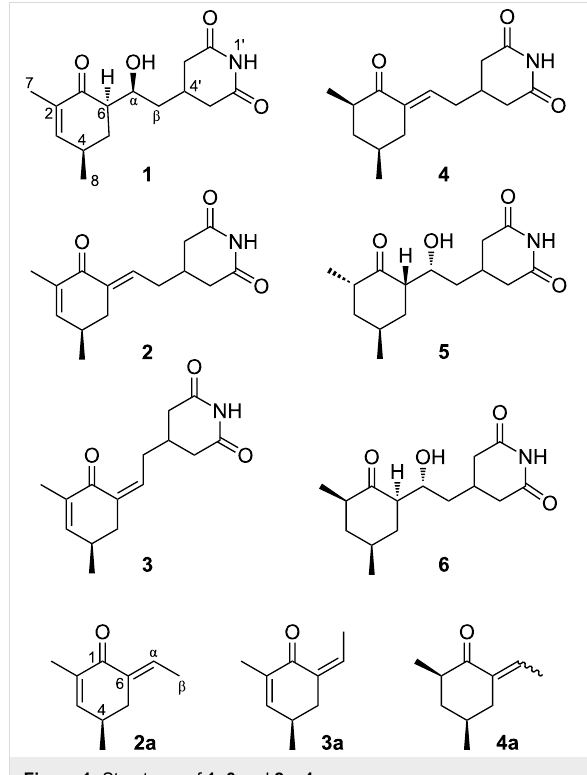
Figure 1: Structures of 1 – 6 and 2a – 4a